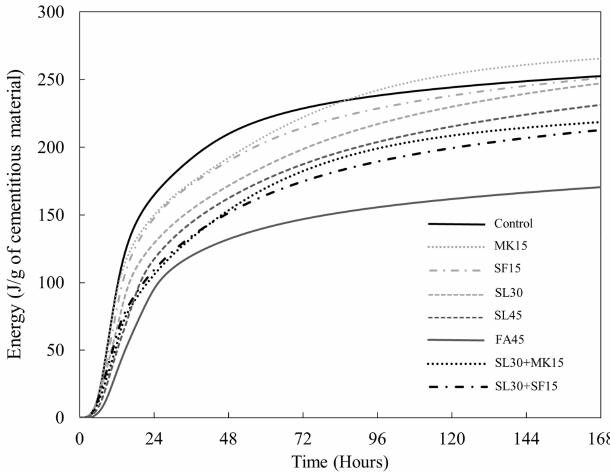
Figure 10. Heat of hydration of the 422 group mixtures to generate pozzolanic reaction.